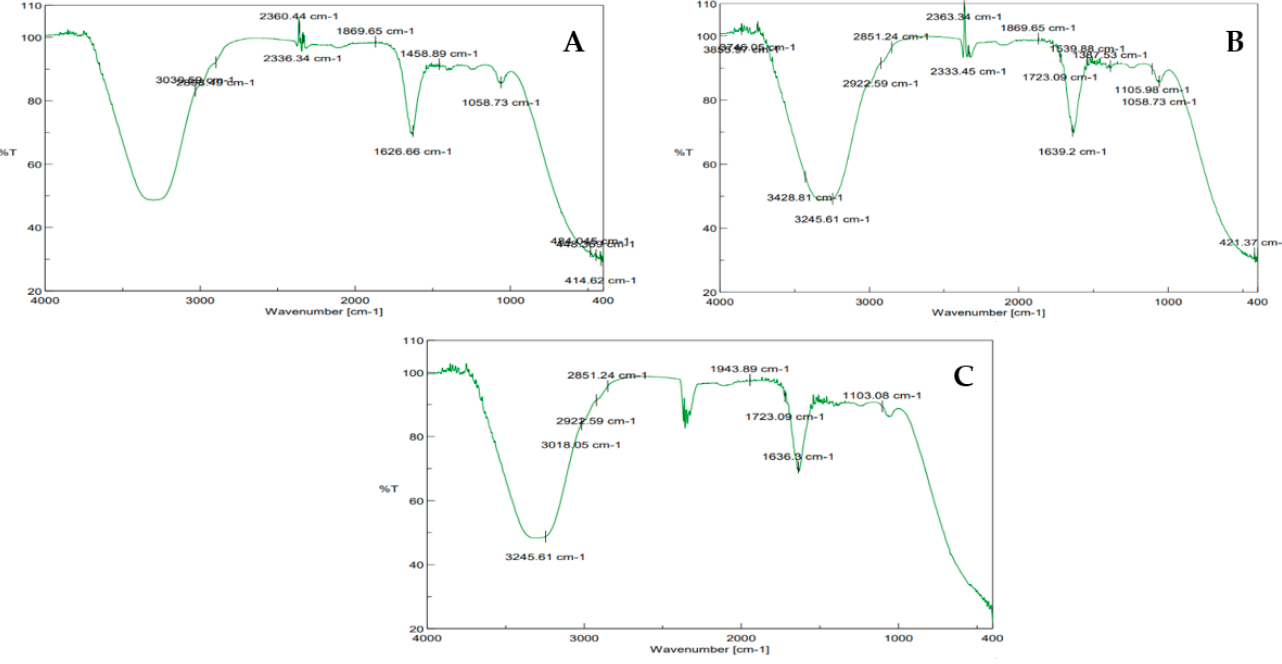
Figure 2. Fourier transforms infrared spectroscopy image of ( A ) PS, ( B ) HA, and ( C ) PS + HA.